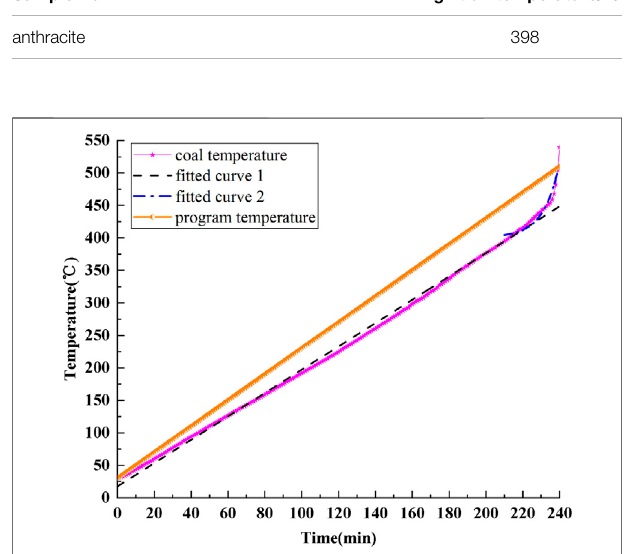
TABLE 3 | The data of ignition temperature of the coal sample. Sample no.